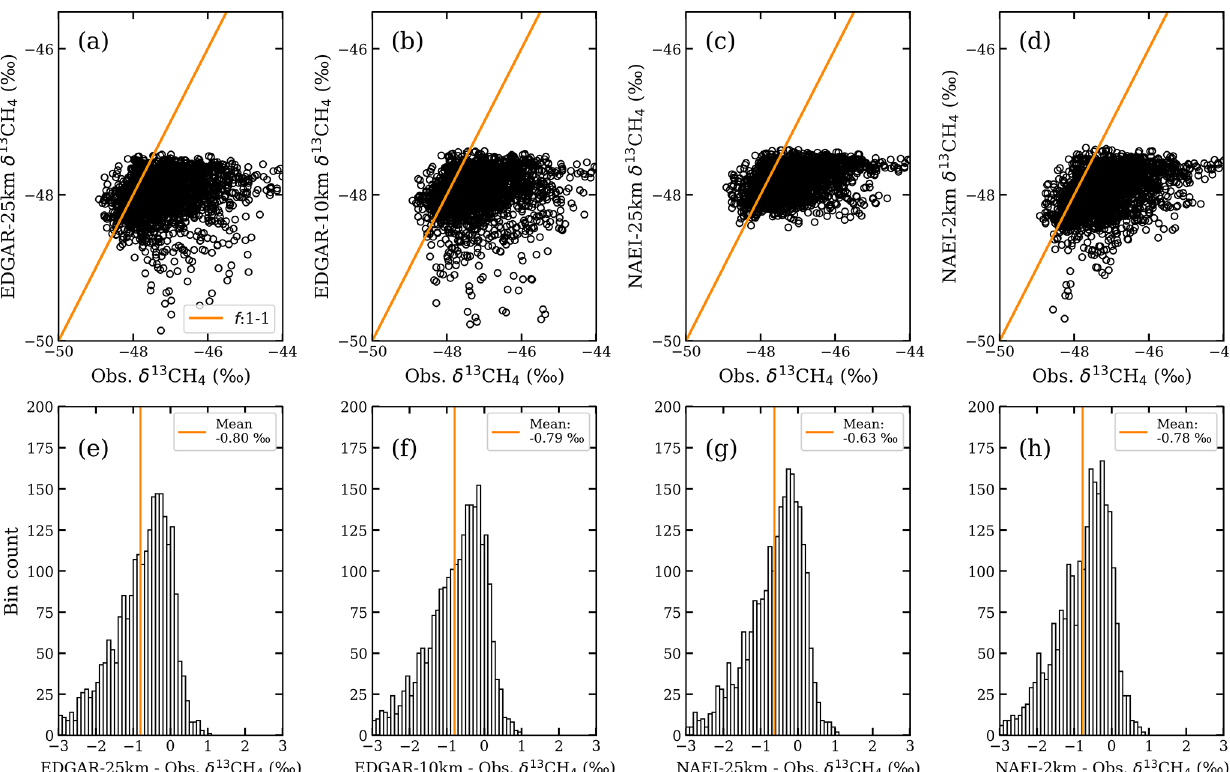
Figure 12. Simulation–observation comparisons of δ 13 CH 4 using point-by-point comparisons (top row) and distributions of the simulation– measurement differences (bottom row) for (a, e) EDGAR-25km, (b, f) EDGAR-10km, (c, g) NAEI-25km, and (d, h)